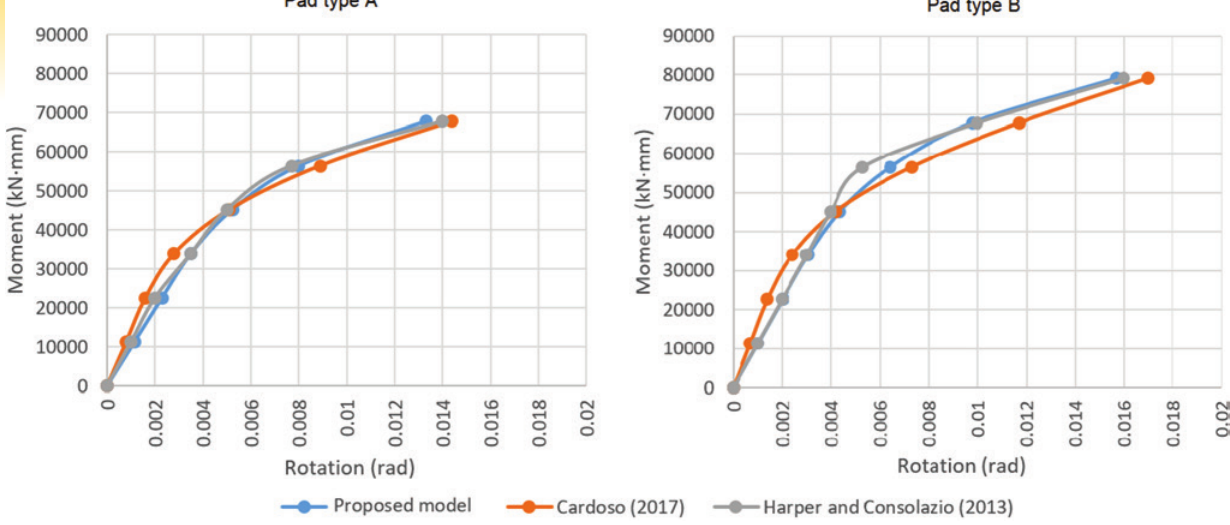
Comparison of the rotation-moment behavior of bearing pads type A and B